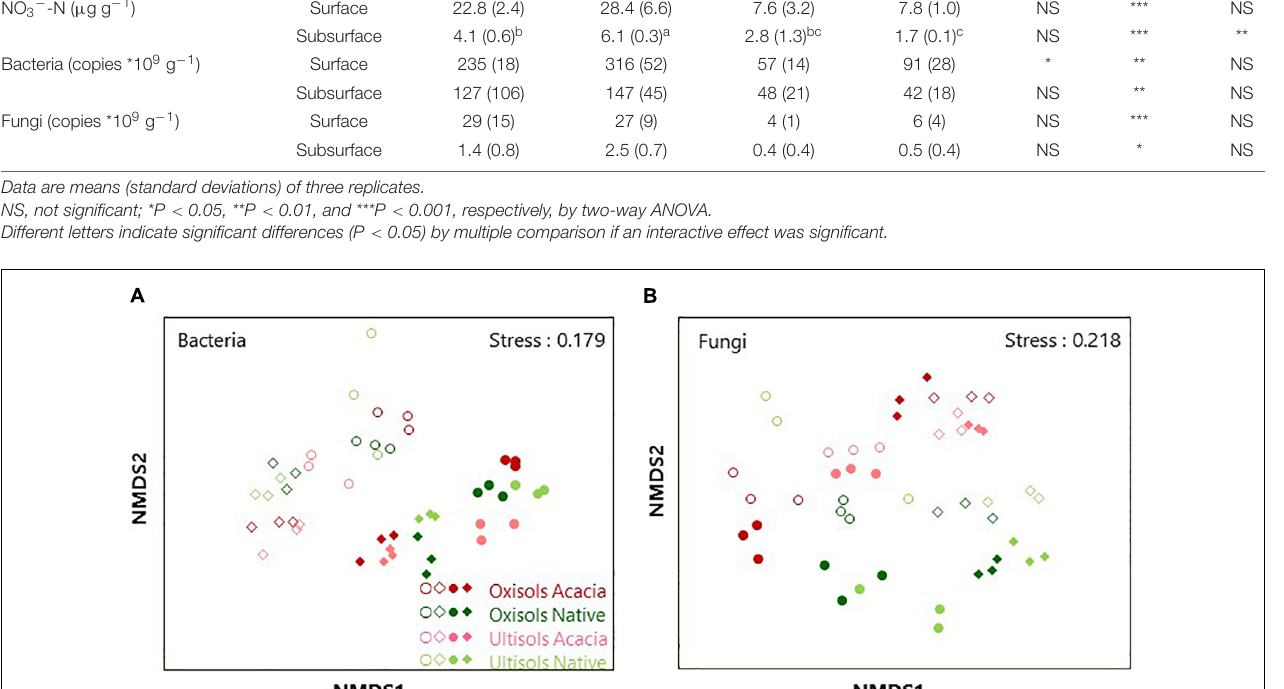
same statistical result as total bacterial OTU richness, which was significantly higher in acacia than in native for Oxisols but not for Ultisols ( Figure 2B and Table 3 ). In addition, the numbers after removing the numbers of OTUs in Chloroflexi from the total numbers were not significantly different between vegetation and between soil types ( Figure 2C ).